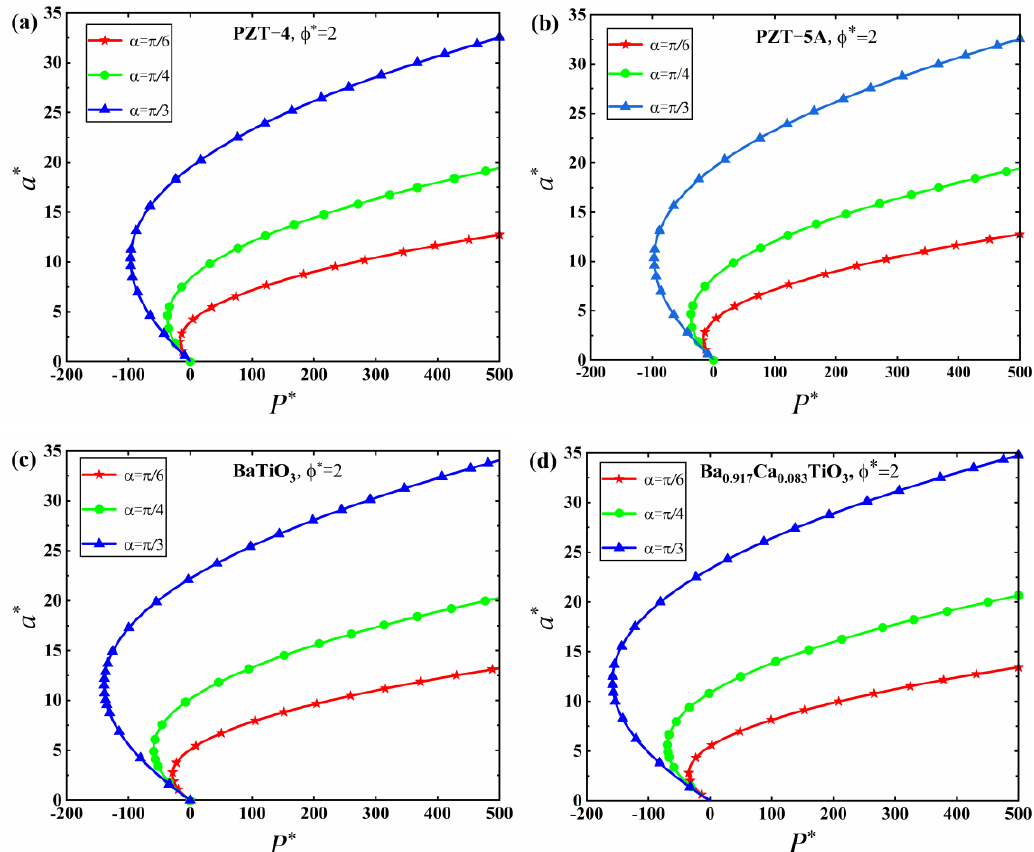
Figure 5. Variation of the dimensionless contact radius, a ∗ , with the dimensionless indentation force, P ∗ , at the different values of α = π /6, π /4 and π /3 for the conducting punch with non-zero electric potential ( φ ∗ = 2). ( a ) PZT-4. ( b ) PZT-5A. ( c ) BaTiO 3 . ( d ) Ba 0.917 Ca 0.083 TiO 3 .